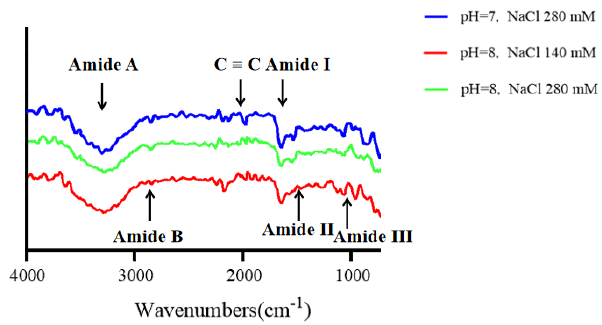
Figure 13. FTIR spectra of lyophilized skin collagen (SC) gels from C. idella under different salinity and pH.